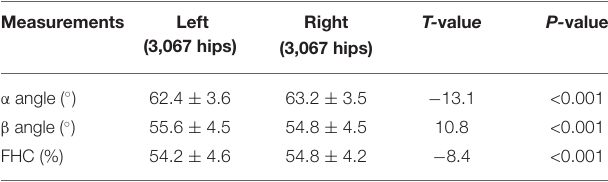
TABLE 1 | Comparison of α angle, β angle, and femoral head coverage between left hips and right hips in normal infants. Measurements